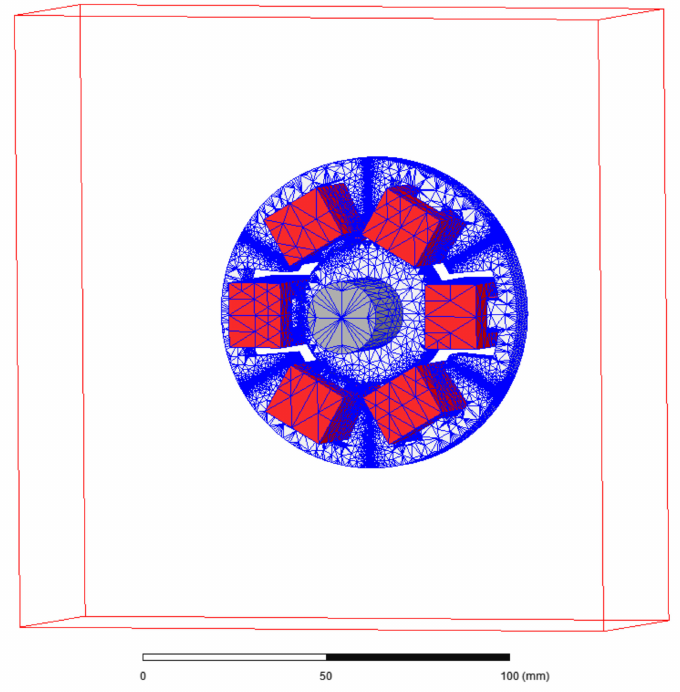
Figure 6. Finite element mesh of the simulation model. To limit the calculation time, the simulation model represented half of the real object. Further simplification of the model included the simple geometry of coils. The zero Dirichlet boundary condition for the magnetic field intensity was set to 40 mm from the stator in every direction. The symmetry plane was placed in the middle of the stator’s length with a zero Neumann boundary condition for the magnetic field intensity. Figures 7 and 8 present magnetic forces F x and F y , while Figure 9 depicts dynamic inductance and velocity-induced voltage. All these parameters were incorporated into the simulation model presented in Figure 5.